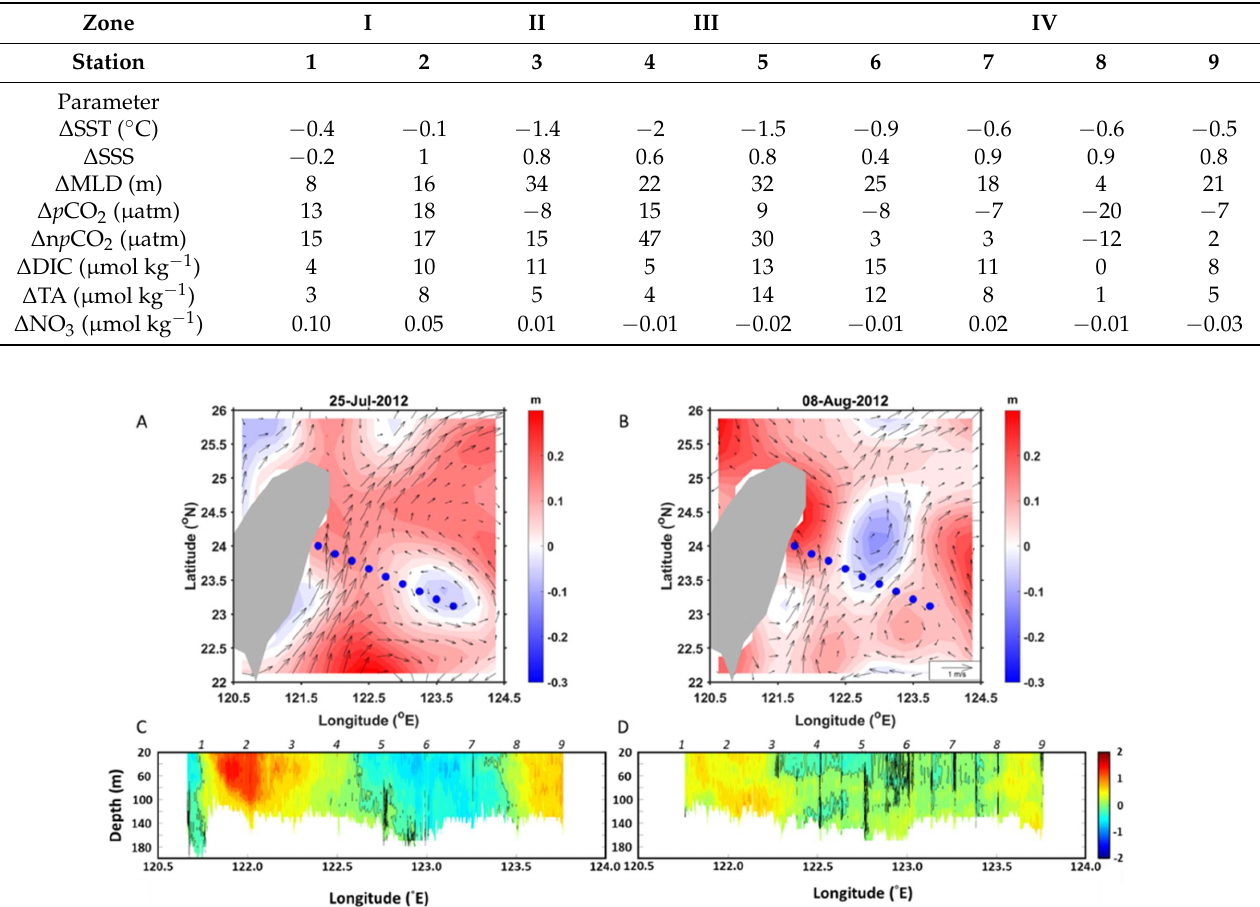
Figure 5. Spatial variations of satellite-observed sea level anomalies (units in meters, color shading, ( A , B )) and geostrophic currents (vectors, ( A , B )), and acoustic Doppler current profiler-observed meridional current velocity profile through the sampling transect offshore of eastern Taiwan ( C , D ), before the typhoon (25 July in A and 27~28 July in ( C )) and after the typhoon (8 August in ( B ) and 4~5 in August ( D )). For clarity, alternate current vectors with two grid points skipping are presented in ( A , B ). The blue circles represent the locations of nine sampling stations in ( A , B ).